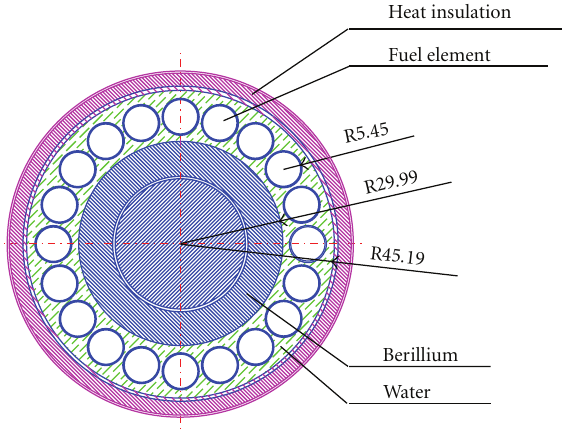
Figure 1: Design variant of fuel rod bundle of thermal reactor with water coolant.